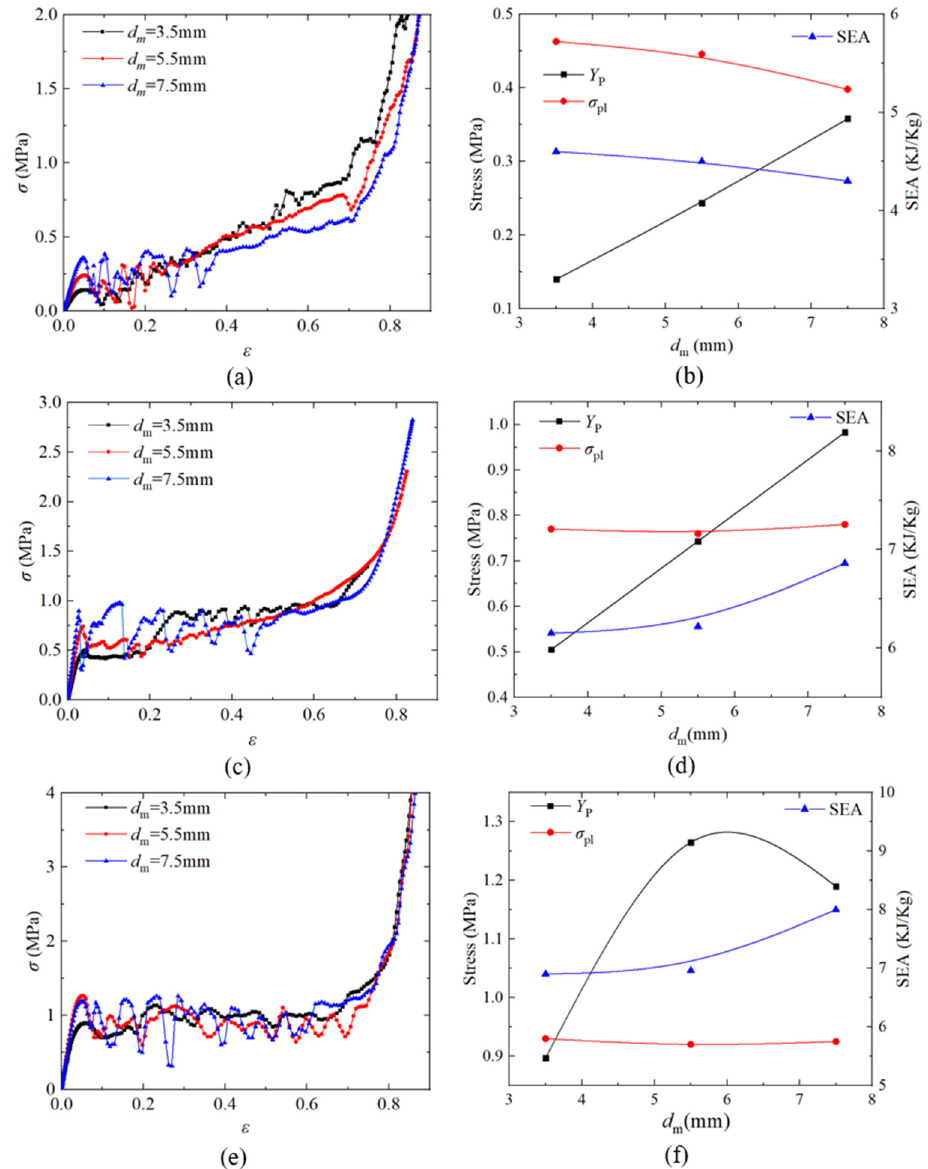
Figure 12. Effect of hole diameter on the nominal stress–strain curve and first peak stress Y P , plateau stress σ pl and SEA of ( a , b ) SC; ( c , d ) BCC and ( e , f ) FCC